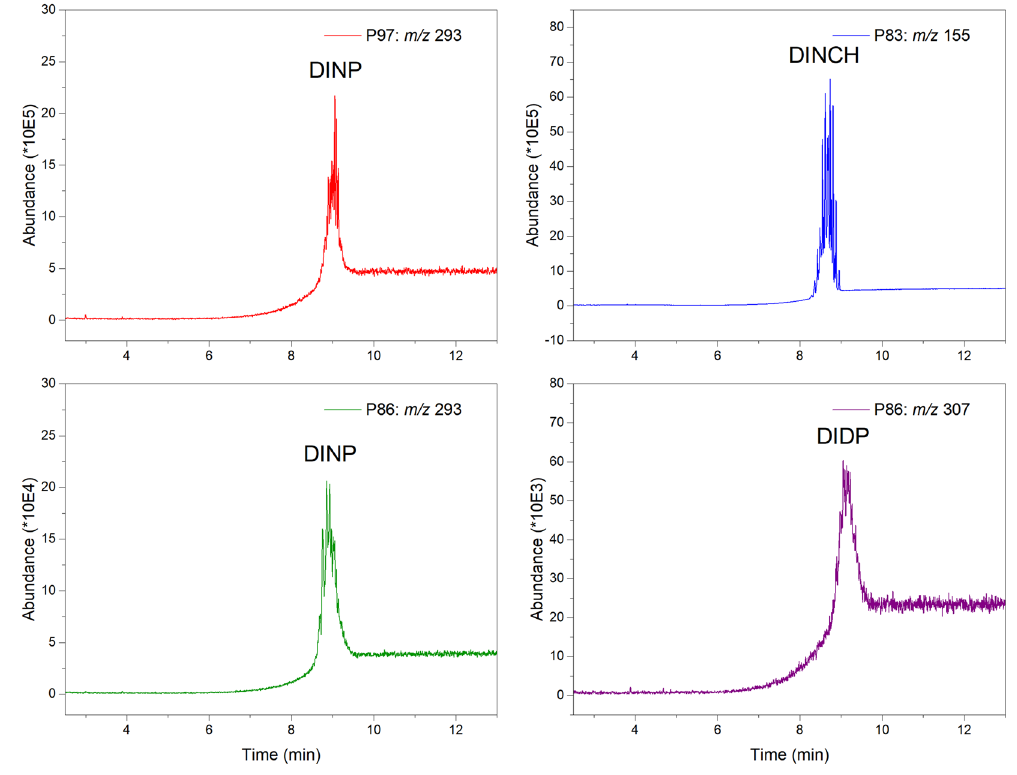
Figure 2. GC–MS chromatograms in SIM mode for plasticizer-specific ion fragments. These are m/z 293 for DINP in sample P97 and sample P86, m/z 307 for DIDP in sample P86 and m/z 155 for DINCH in sample P83.